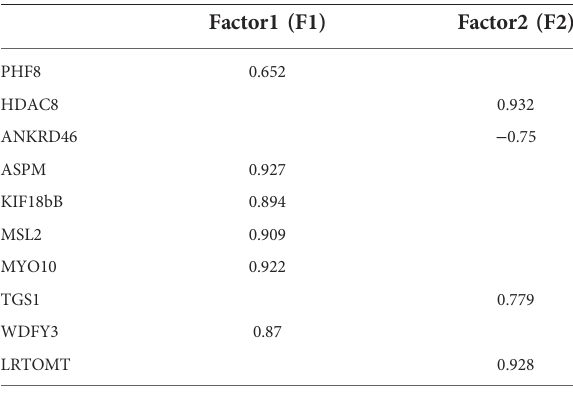
TABLE 3 Factor loading (rotated) matrix of key proteins. a